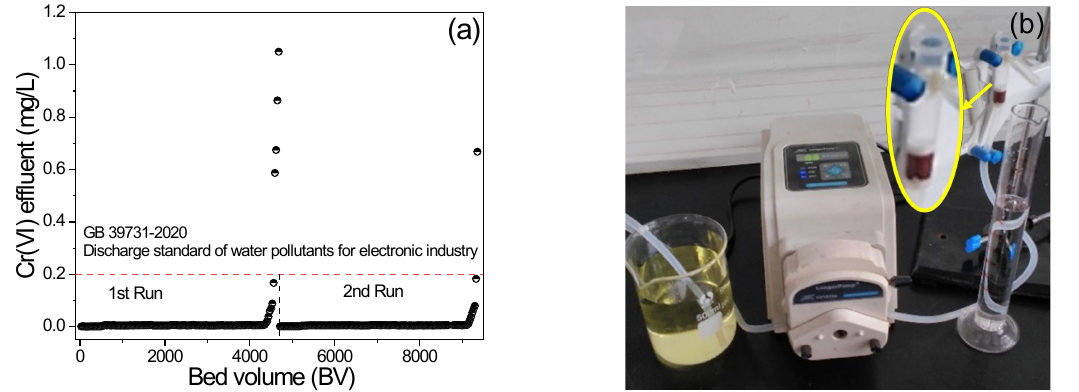
Figure 7. Breakthrough curves for adsorption of Cr(VI) onto PAN/APNs ( a ); fixed-bed column ex- periments ( b ) (fixed bed was the tube in enlarged image; bed volume = 0.78 cm 3 , C 0 = 10 mg/L, flow rate = 30 BV/h, pH = 2).